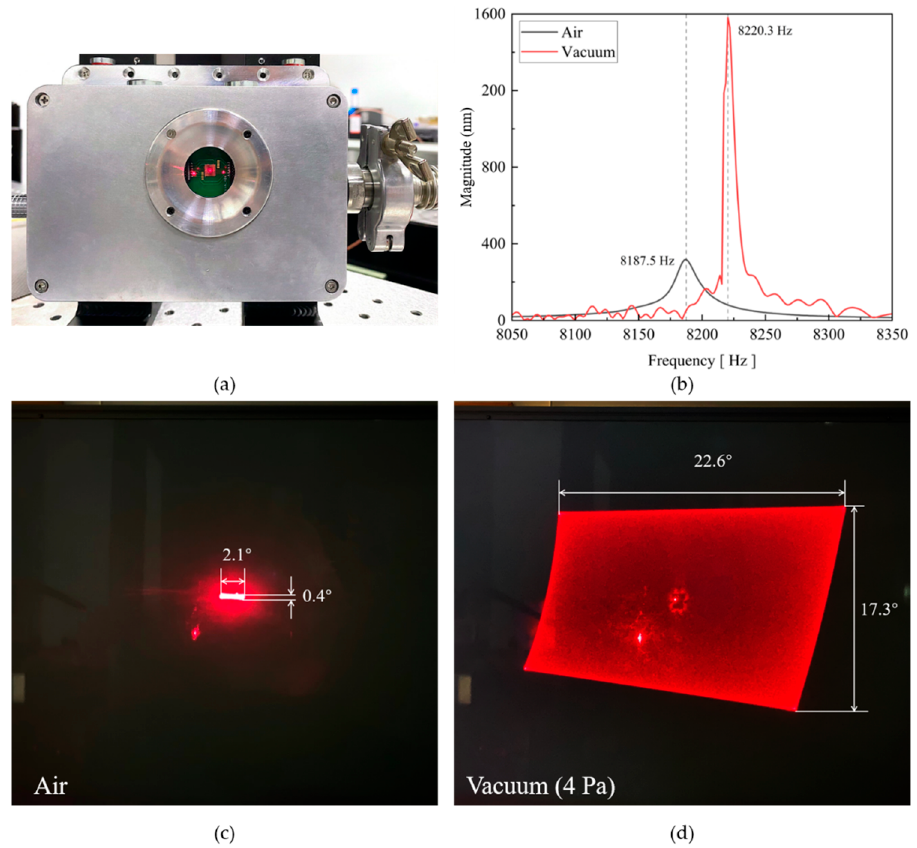
Figure 12. ( a ) Vacuum chamber with glass viewport. ( b ) Frequency responses of Mirror II-2 in air (black line) and vacuum (red line). ( c ) Biaxial scanned laser beams of Mirror II-2 at atmosphere and ( d ) under vacuum condition (4 Pa) .